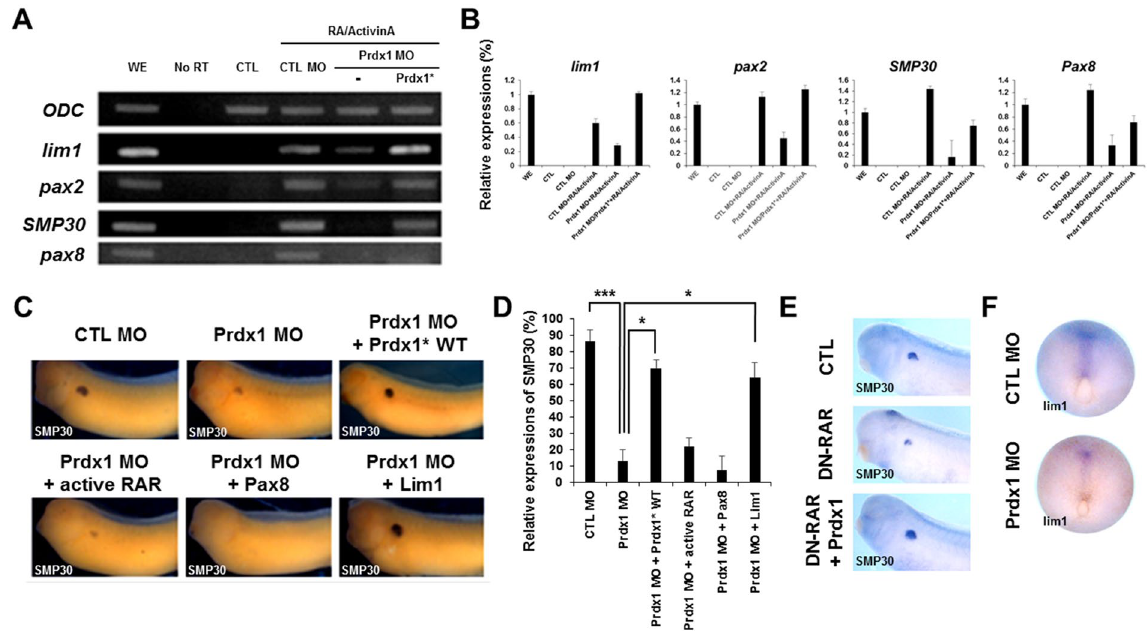
Figure 3. Prdx1 functions downstream of the RA signaling pathway during proximal tubule formation in the pronephros. ( A ) prdx1 MOs (40 ng) were injected into both blastomeres of two-cell stage embryos. Animal caps were removed from the injected embryos at the stage 8.5 and incubated with 10 ng/mL activin A, followed by 10 − 4 M all-trans RA for 3 h. Animal caps were collected from embryos at the stage 33 and used for RT-PCR. RT- PCR results showed the significant reduced expression of lim1 , pax2 , smp30 , and pax8 in prdx1 MO-injected as compared with RA/activin induced. The decreased expression of pronephros markers was rescued by prdx1 * RNA. Ornithine decarboxylase ( odc ) was used as the loading control. A no-RT template in the absence of reverse transcriptase was used as the control. WE, whole embryo; CTL, control animal caps; CTL MO, control MO-injected animal caps. ( B ) RT-PCR examination of lim1, pax2, smp30 and pax8 expression was confirmed by real time PCR. Significant lower expression level was observed for pronephros markers in the prdx1 MO- injected embryos that was rescued by co-injection with prdx1 * RNA except for pax8 . WE, whole embryo; CTL, control animal caps; CTL MO, control MO-injected animal caps. ( C ) prdx1 MOs (40 ng) were co-injected with wild-type prdx1, RAR α -vp16 (active rar ), pax8 , or lim1 (400 pg) into both blastomeres of two-cell stage embryos. Embryos at the stage 33 were used for whole-mount in situ hybridization, and proximal tubules in the pronephros were visualized with a smp30 probe. The pronephros abnormalities of prdx1 morphants were rescued by lim1 mRNA co-injection but not by the activation of active RA receptors or pax8 . ( D ) Graphical representation of pronephros development in prdx1 MO-injected embryos and embryos co-injected with lim1 , active RA receptors and pax8 compared to the control embryos (injected with control MO). Pronephros defects were significantly rescued by lim1 mRNA co-injection. ( E ) Embryos at two-cell stage were injected with dominant-negative retinoic acid receptor ( DN-RAR ) with or without prdx1 . DN-RAR -inhibited pronephros development was rescued by prdx1 overexpression . ( F ) Expression of pronephros marker lim1 was observed at stage 12.5 in embryos injected with CTL MO and prdx1 MO. lim1 expression was dramatically reduced in Prdx1